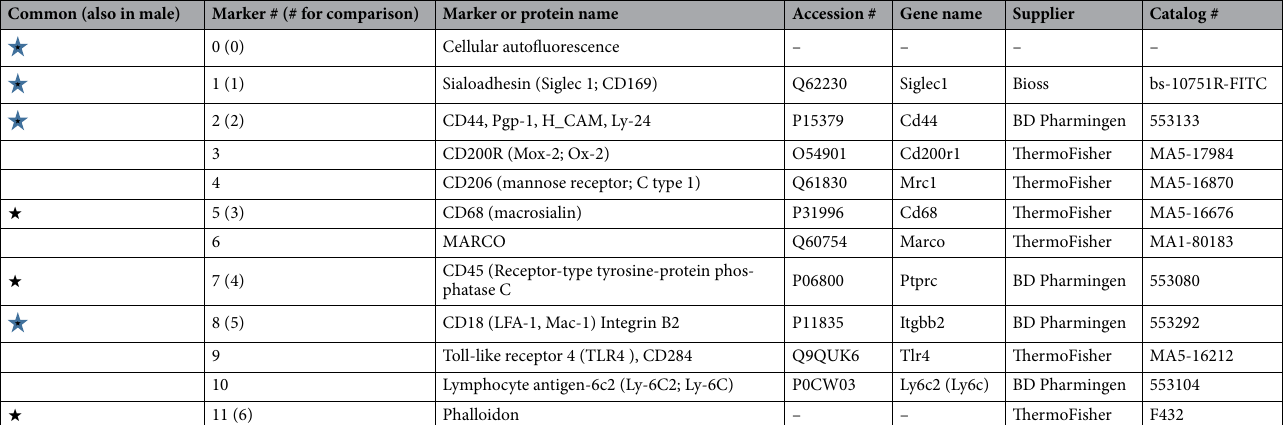
Table 1. Markers for female rescue and sex comparison study. List of markers: The markers used in this study are listed together with the accession number, gene name, supplier, and catalog number. The TIS software automatically assigns the first marker as marker #0. Markers that were in common with male rescue study 29 are indicated ( ★ ) and the numbers assigned for comparison (# for comparison) are indicated in